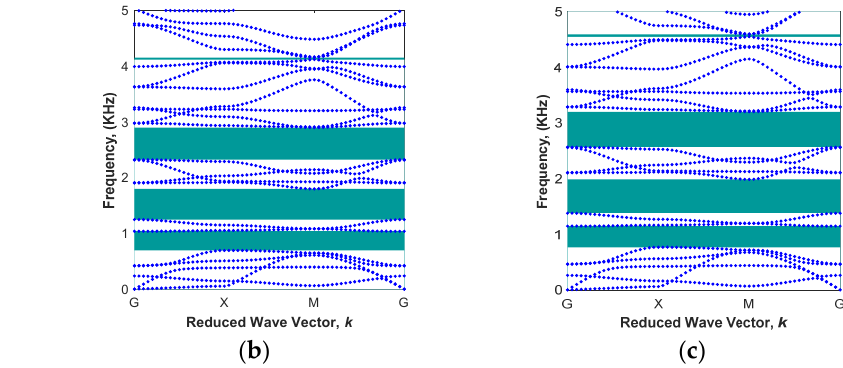
Figure 9. Various band structures in different iron volume fractions with the fixed cylindrical core radius of L / R = 5 and the fixed arm angle θ = 0: ( a ) φ = 6.08%; ( b ) φ = 11.47%; ( c ) φ =